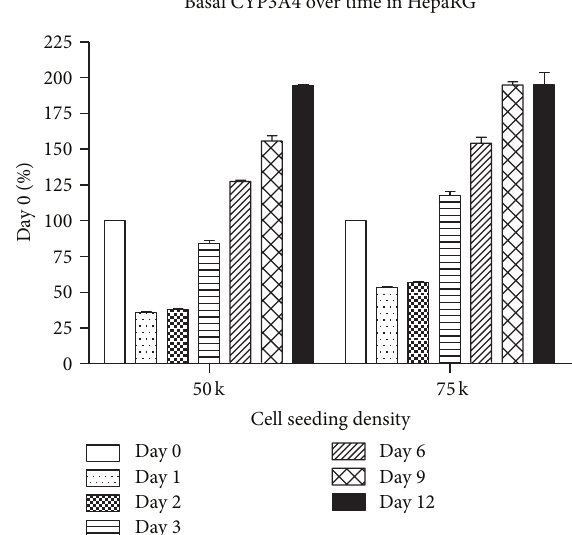
Figure 3: Basal CYP3A4 activity over time in culture. HepaRG cells were plated at 50,000 and 75,000 cells per well and CYP3A4 basal activity was measured over 12 days of continuous culture following